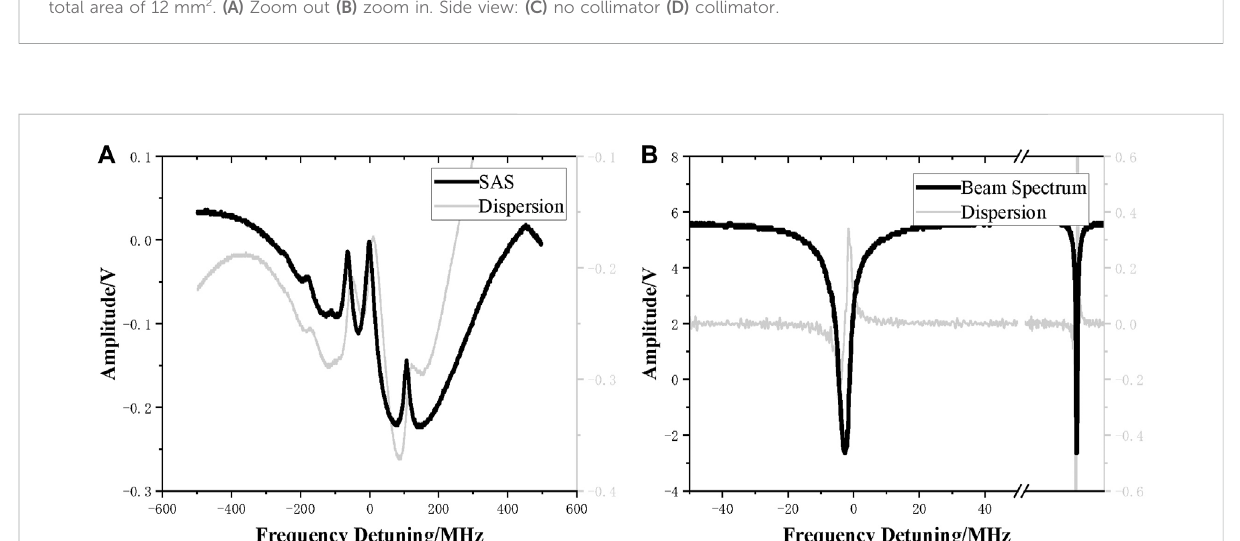
FIGURE 4 Laser stabilization spectroscopy of the OPCB. (A) Saturated absorption spectrum. (B) Atomic beam